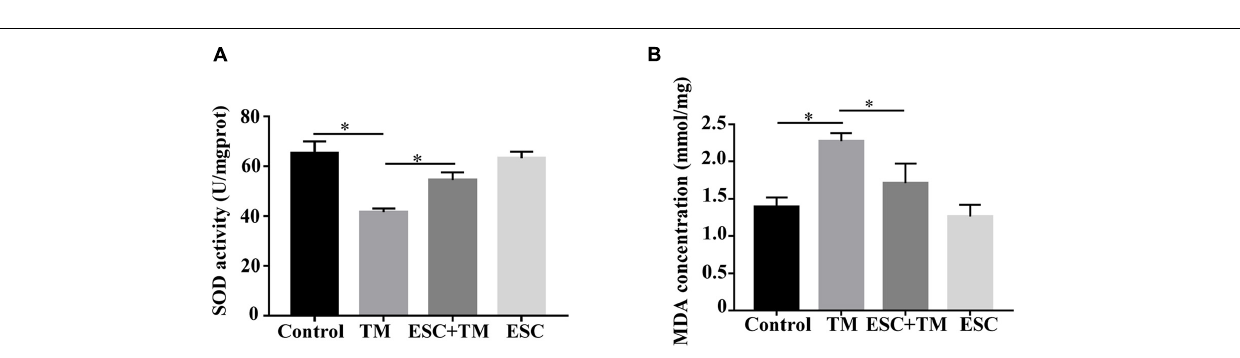
FIGURE 5 | Effect of escitalopram on oxidative stress of bEnd.3 cells. (A) Superoxide dismutase (SOD) activity. (B) Malondialdehyde (MDA) concentration. ∗ p < 0.05. Results were shown as the mean ±